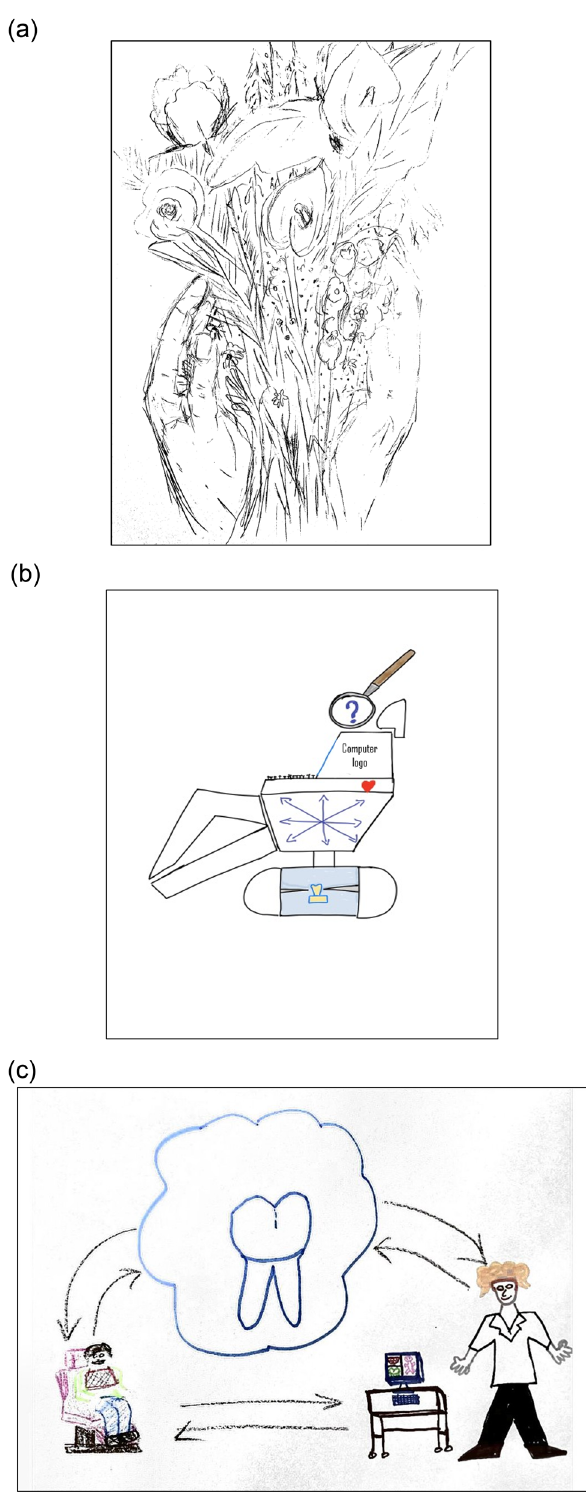
Fig. 2 Three artwork created by dentistry faculty members (Baby Boomers and Generation X) showing some features illustrating the two Themes for this group (see Table 2). Theme 1: Image ( c ) a patient sitting in an outdated chair, (rather than lying down), an old computer model, a dentist wearing short sleeves lab coat, no gloves, absence of head loupes and relatively long and loose hair; evokes the positive traditional care and patient-dentist interaction (both persons are smiling). Along with this, the distance between patient and dentist (each one in one corner of the drawing) seems to make the diagnosis and treatment planning more challenging (the big tooth and arrows minimizing the gap for a comprehensive care) – which reminds the challenges caused by the pandemic situation nowadays. A positive, compassionate, and supportive feeling remains amongst people in these dif fi cult times, with an environ- ment that is pleasing and worthwhile: image ( a ) contains hands holding fl owers that appear to be a gift. Theme 2: Image ( b ) contains a tooth mounted in a typodont as a base for the dental chair, suggesting the preclinical setting, one of the bases of clinical dentistry. The small red heart reminding the patients. The loupe with a question mark, remembering that there are multiple ways (arrows on the computer screen) to investigate the patient ’ s